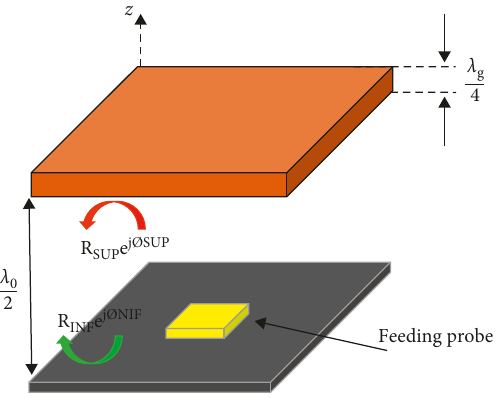
Figure 1: Classical EBG antenna fed by a